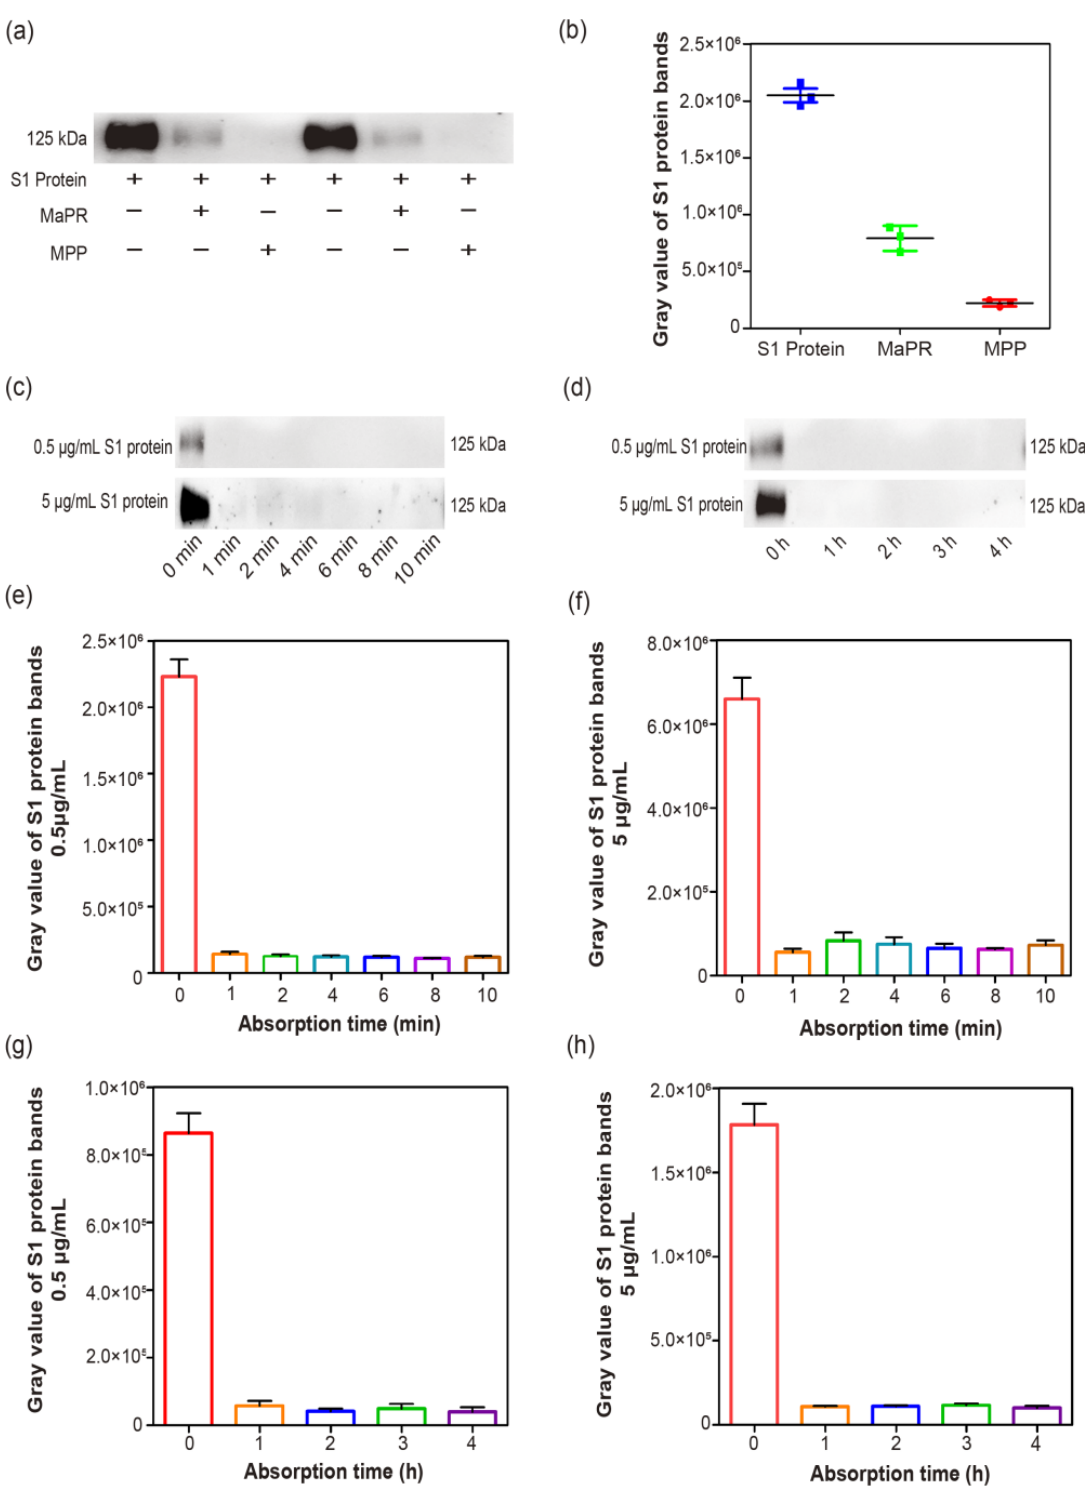
Figure 3. The expression of remaining SARS-CoV-2 S1 protein and the adsorption stability of MPP was analyzed by western blot. ( a ) Expression of SARS-CoV-2 S1 protein in solution after adsorption; ( b ) Gray value analysis of SARS-CoV-2 S1 protein band; ( c ) Expression of SARS-CoV-2 S1 protein in solution after MMP adsorption for 10 min; ( d ) Expression of SARS-CoV-2 S1 protein in solution after MMP adsorption for 4 h; ( e – h ) Gray value analysis of SARS-CoV-2 S1 protein band.